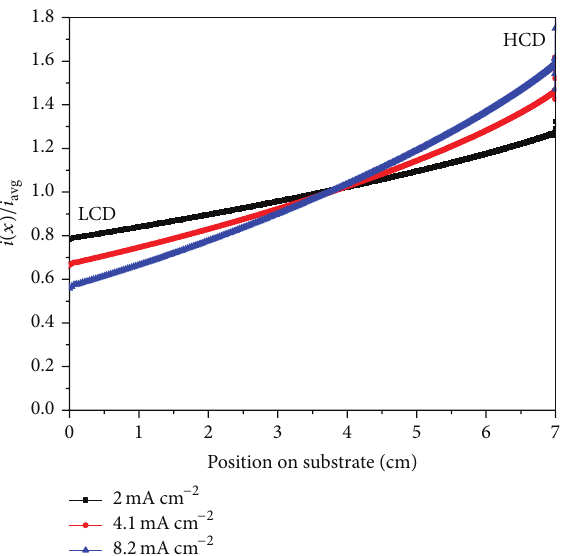
Figure 10: Tertiary current distribution for modified Hull cell during Cu electrodeposition carried out at different applied average current densities of 2, 4.1, and 8.2 mAcm −2